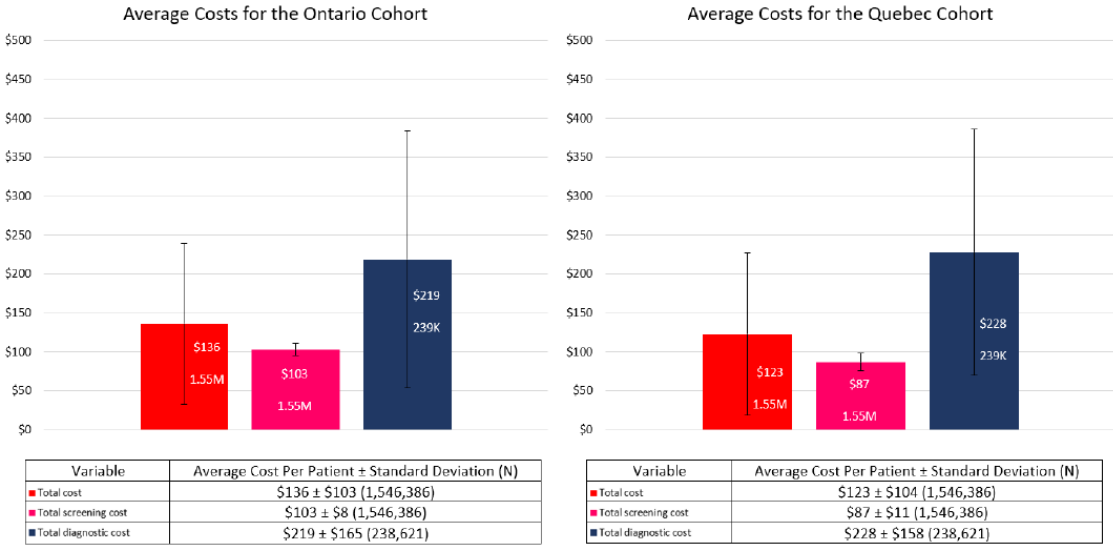
Figure 3. Comparison of Ontario and Quebec Average Cost Per Woman Per Month.